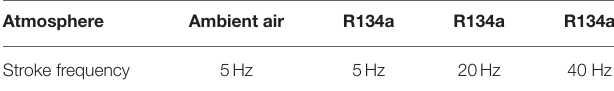
TABLE 4 | Test frequencies and